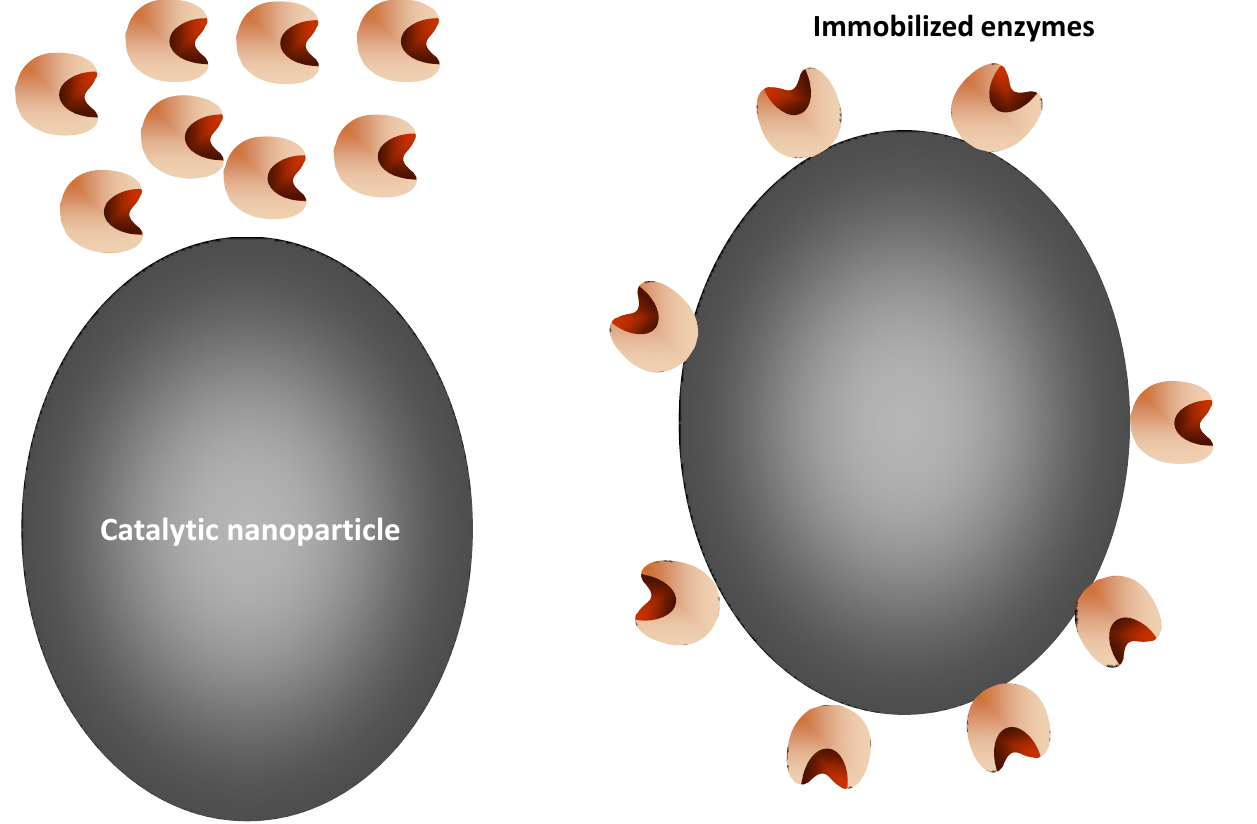
Figure 5. Preparation of enzymes immobilized in metal catalyst